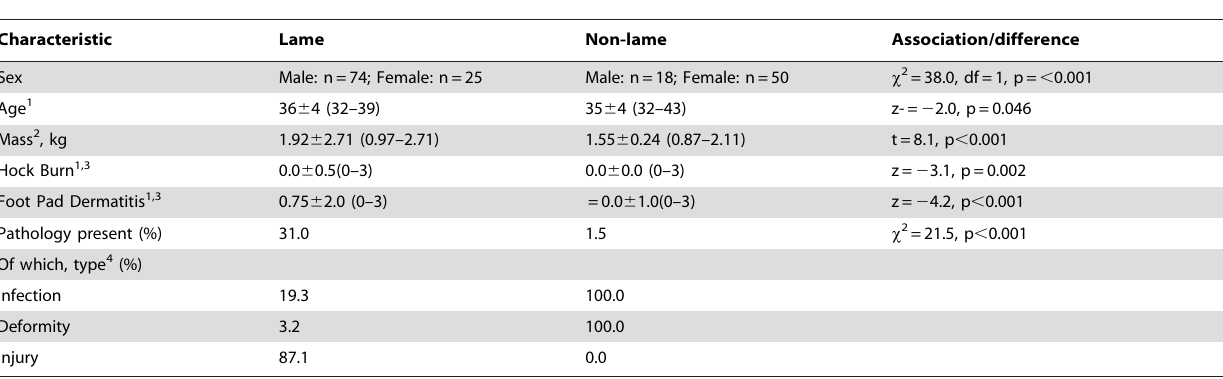
Table 1. Key sample characteristics for Part 1 test